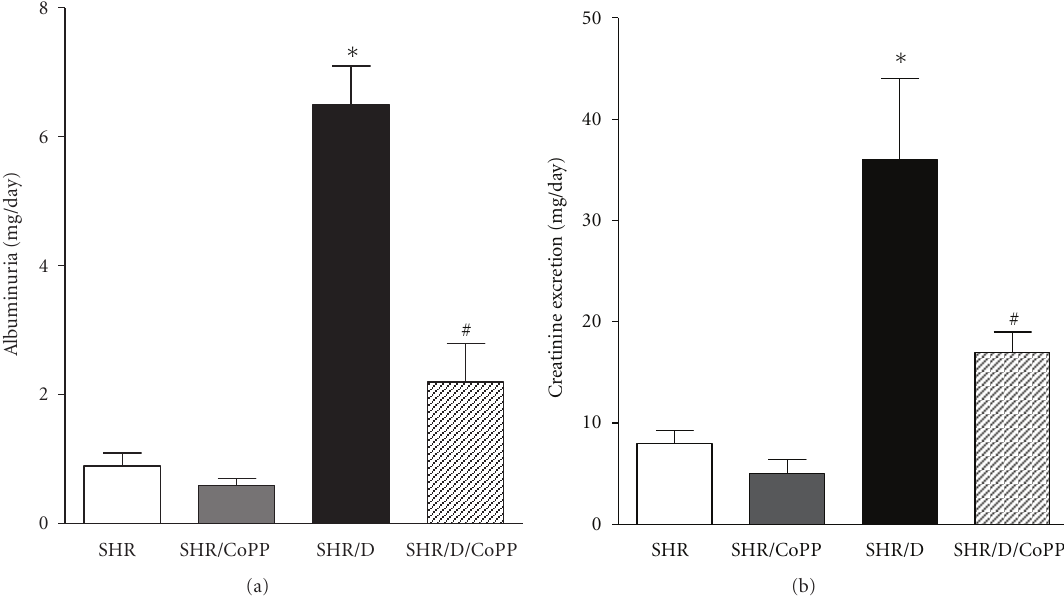
Figure 2: Urinary albuminuria (a) and creatinine excretion (b) in control and diabetic SHR with or without CoPP ( n = 8, ∗ indicates significant di ff erence from control SHR and # indicates significant di ff erence from diabetic SHR).